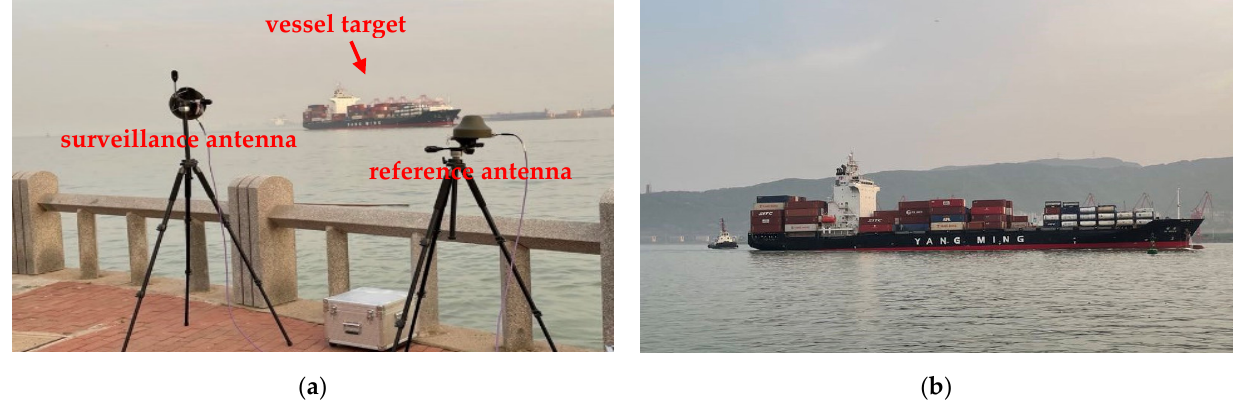
Figure 10. Maritime experiment: ( a ) receiving system, ( b ) vessel target.